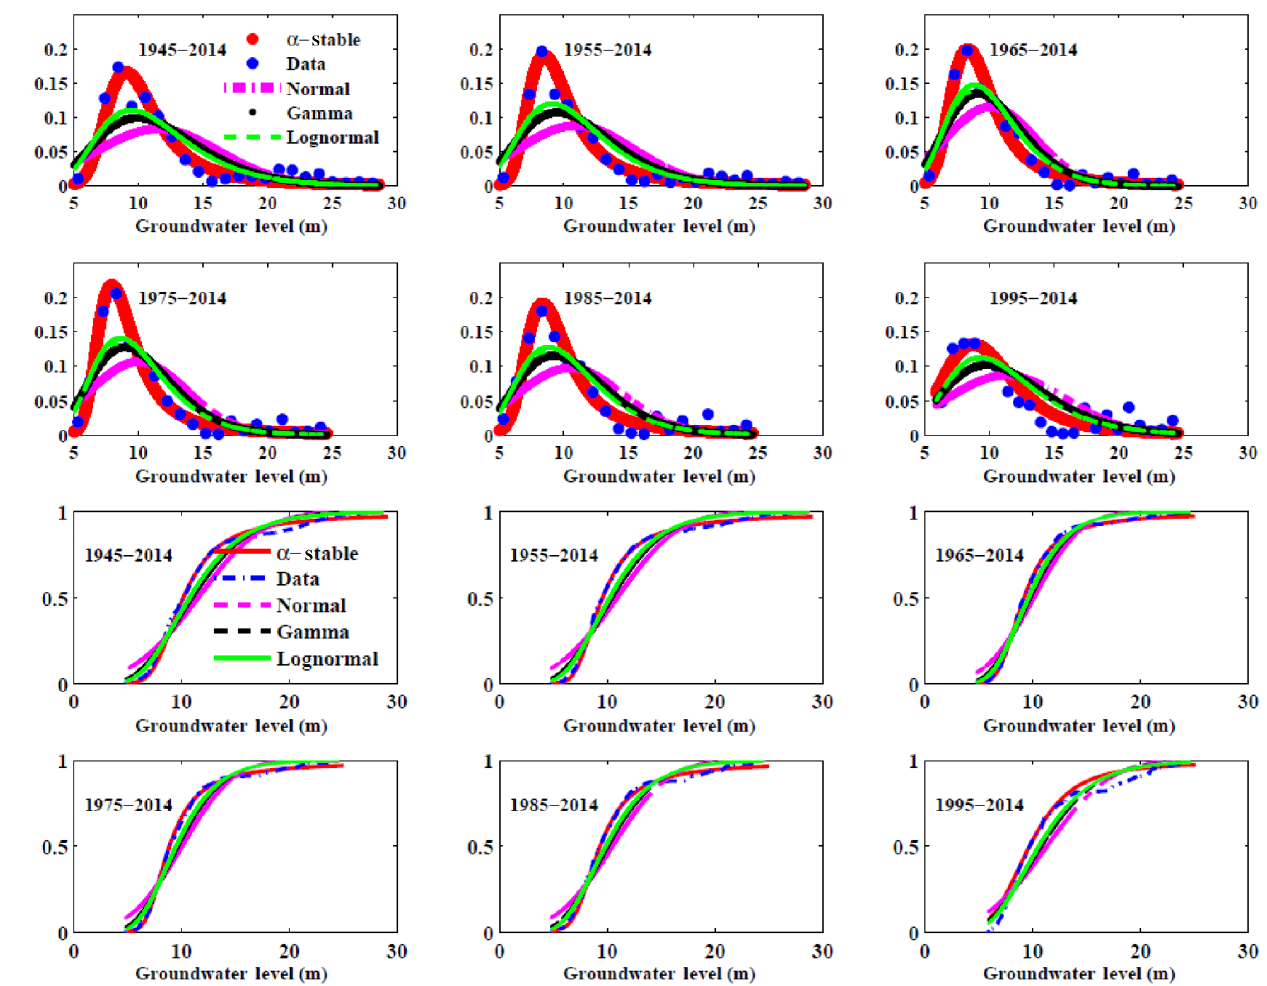
Figure 12. Probability density function and cumulative distribution function (first two rows and last two rows, respectively) of groundwater level fluctuation time series data of Well